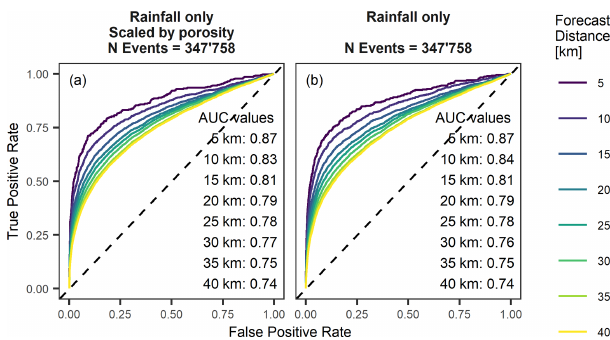
Figure 11. ROC curves and AUC values of model fits (a) based on normalized rainfall information scaled by porosity and (b) based on normalized rainfall information only for all 133 sites and the entire modelling period